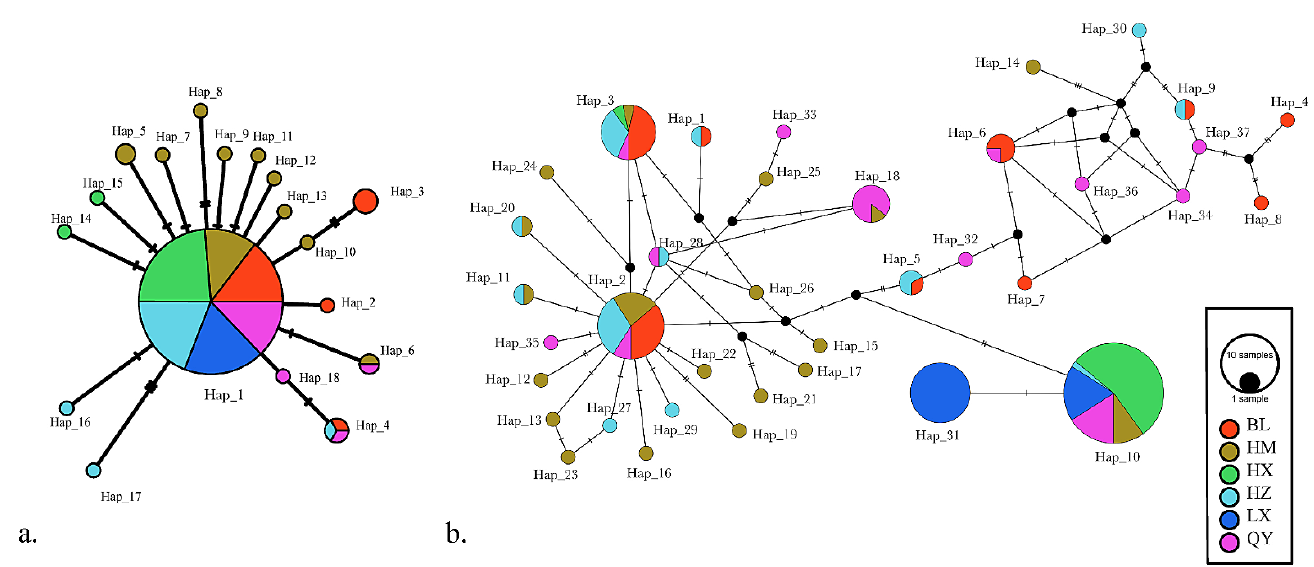
Figure 4. Median-joining network of haplotypes of ( a ) mitochondrial cyt b (18 haplotypes) and ( b ) D-loop (37 haplotypes) sequences. The frequency is represented by the circle size and numbers. Each black dot suggests one mutational step. Different colors represent different localities. Table 2. Summary statistics for the 5 microsatellite